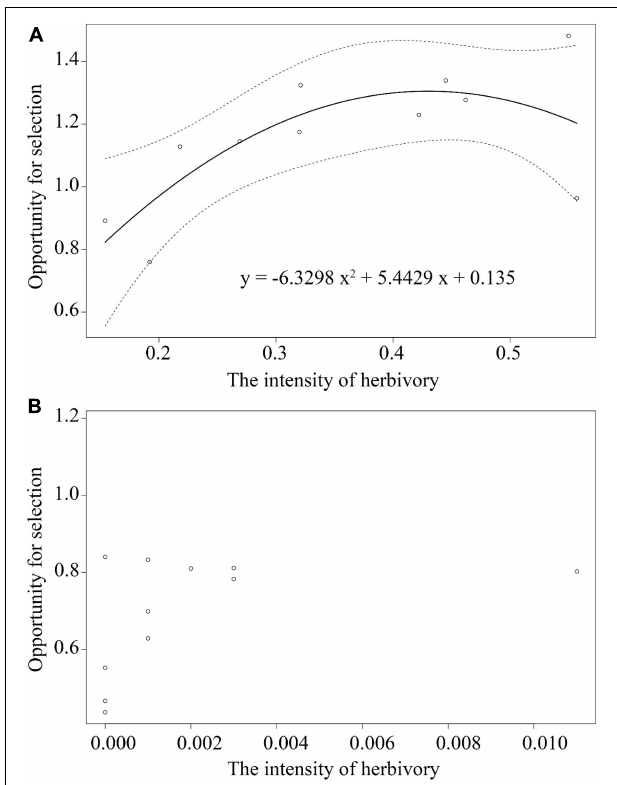
FIGURE 4 | Nonlinear relations between the opportunity for selection and herbivory intensity among the herbivore present treatment plants (A) and among the herbivore exclusion treatment plants (B) among 11 populations of Primula florindae . The best-fit model for HP treatment is provided. The dashed lines represent the 95% confidence interval of the fitted